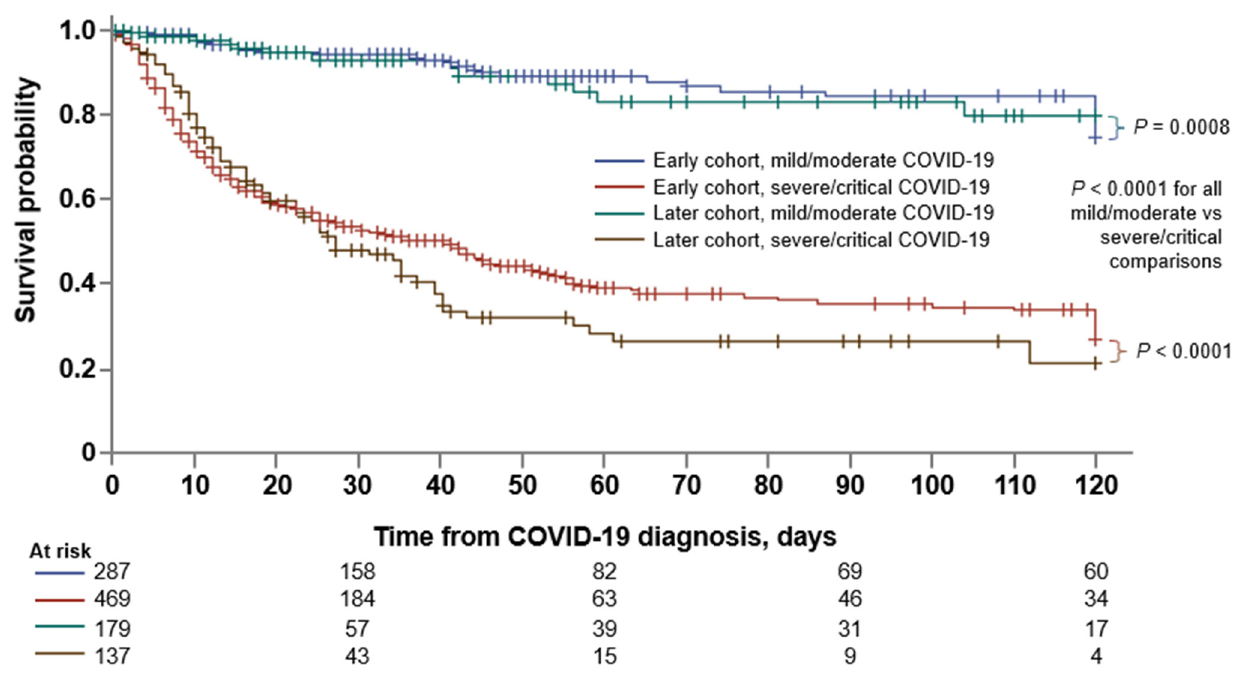
Figure 2. Survival estimates according to period of COVID-19 diagnosis and clinical severity of disease. Kaplan–Meier estimates of survival from time of COVID-19 diagnosis according to the period in which patients were diagnosed (early cohort vs. later cohort) and the clinical severity of COVID-19 (mild/moderate vs. severe/critical). p values by log rank test, with Šidák correction for multiple comparison.